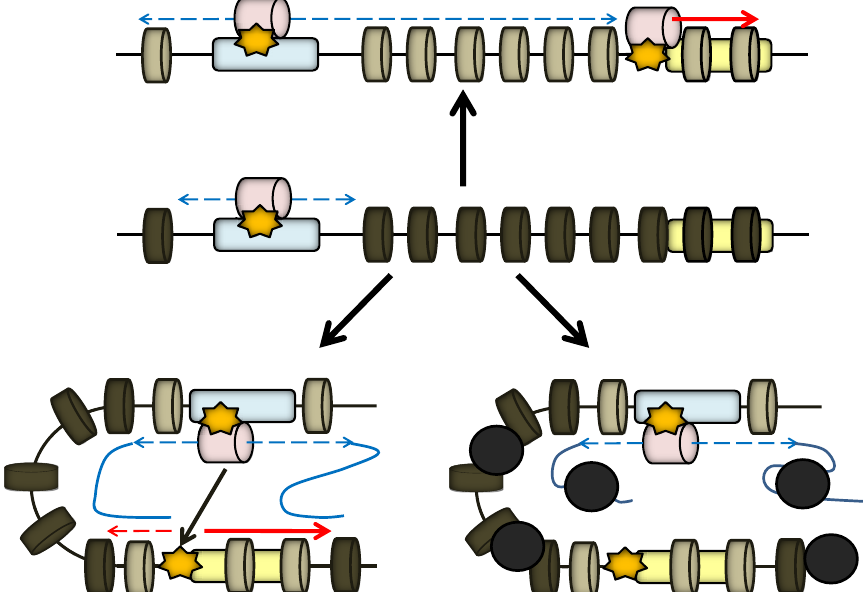
Figure 2. The role of transcription complex recruitment and transcription initiation at enhancers. The diagram in the middle depicts a hypothetical gene locus with a gene (yellow) regulated by an enhancer element (blue). The nucleosomes (small cylinders) are colored dark grey, symbolizing an inaccessible configuration. A transcription complex is recruited to the enhancer, and transcription through the enhancer keeps this element in an open configuration. Upon differentiation, the enhancer activates transcription of the linked gene according to three different scenarios. The mechanism depicted on top shows that tracking of the transcription complex along the chromatin fiber reconfigures the chromatin and renders the promoter accessible, so that transcription factors and RNA Pol II can be recruited to the gene. The model in the lower left indicates that RNA generated from the enhancer and RNA generated from the promoter interact and stabilizes interactions between promoter and enhancer, which facilitates the transfer of activities from the enhancer to the promoter. The model in the lower right indicates that enhancer generated transcripts serve as acceptors for repressor proteins and that the removal of the repressors allows activation of the promoter. The yellow star represents a DNA binding transcription factor. Nucleosomes are represented as light grey (accessible) or dark grey (inaccessible) cylinders. RNA polymerase II transcription complexes are represented as pink cylinders. The blue and yellow boxes represent enhancers and promoters, respectively. The blue and red arrows and lines represent RNAs generated from enhancers (blue) or promoters